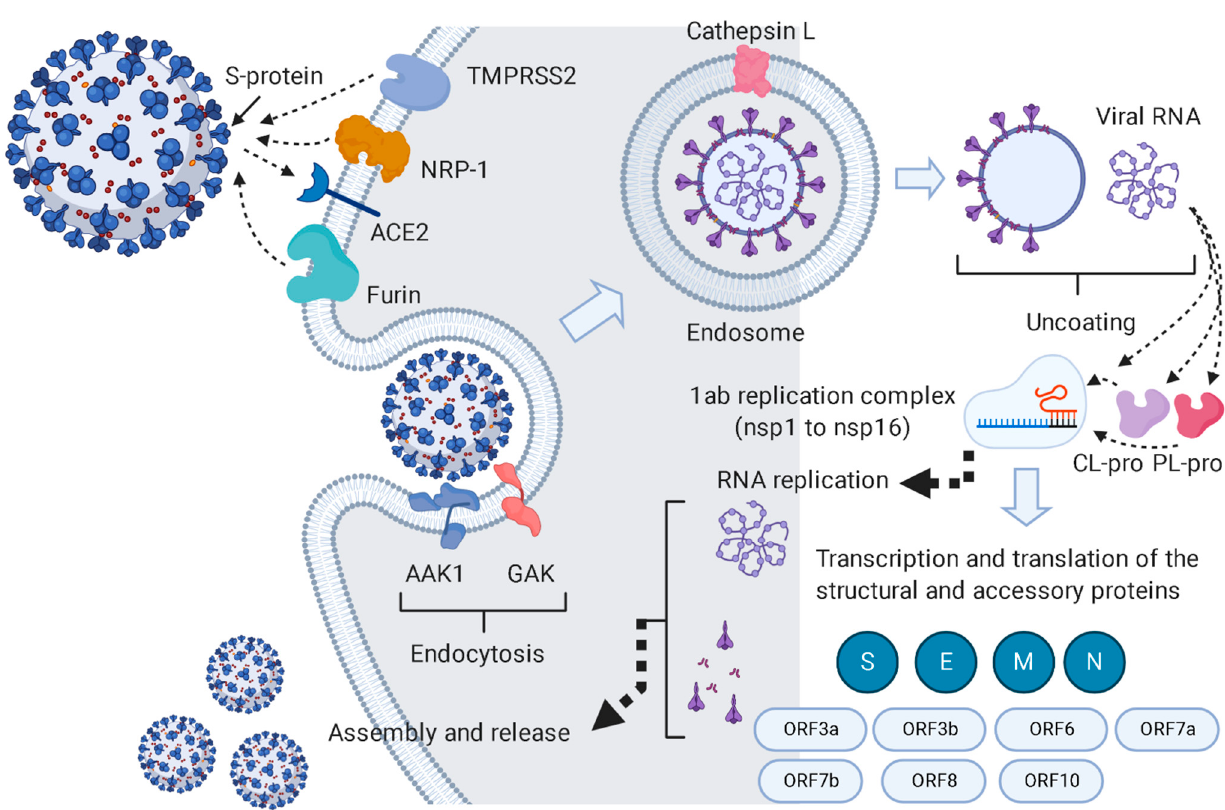
Figure 1. This pathway summarizes the pathogenesis of SARS CoV-2 inside the host cell and indicates the key proteins involved in the viral life cycle. This pathway was constructed with data retrieved from the KEGG website (https://www.genome.jp/kegg-bin/show_pathway?hsa05171+H02398; accessed on 13 December 2020).